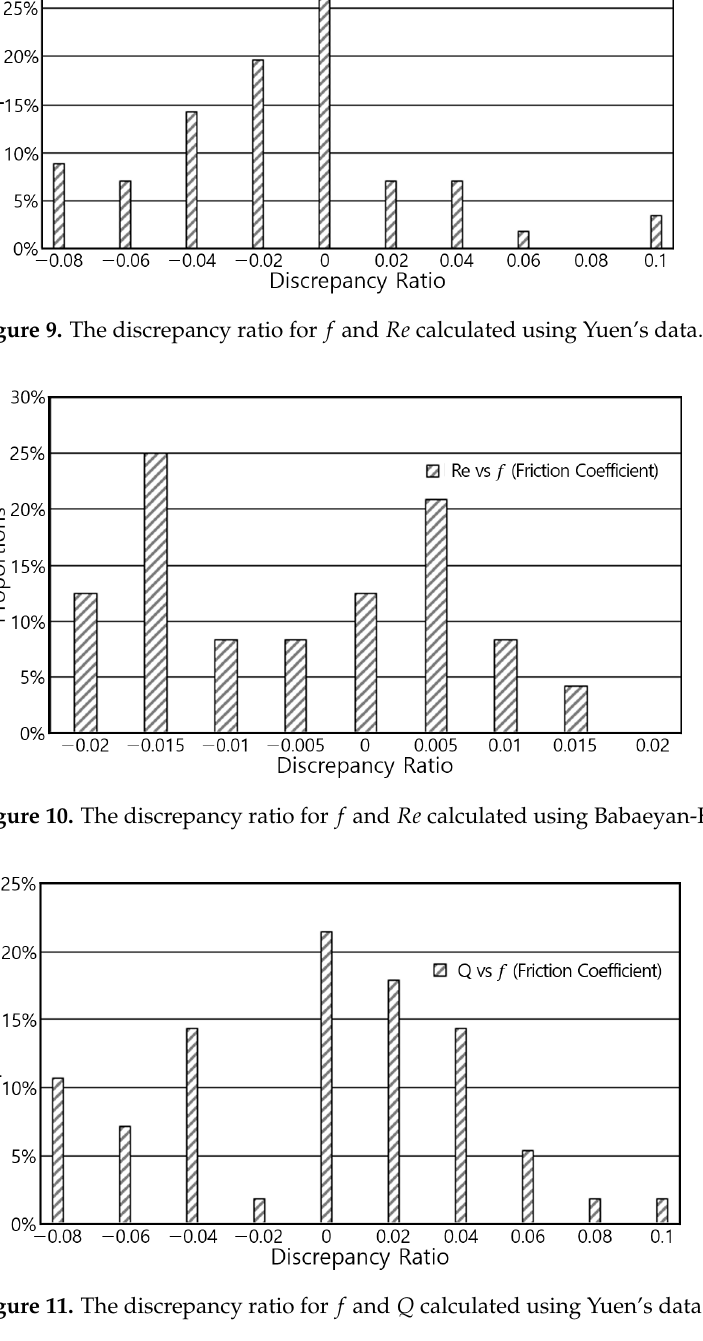
Figure 11. The discrepancy ratio for (cid:1858) and (cid:1843) calculated using Yuen’s data.